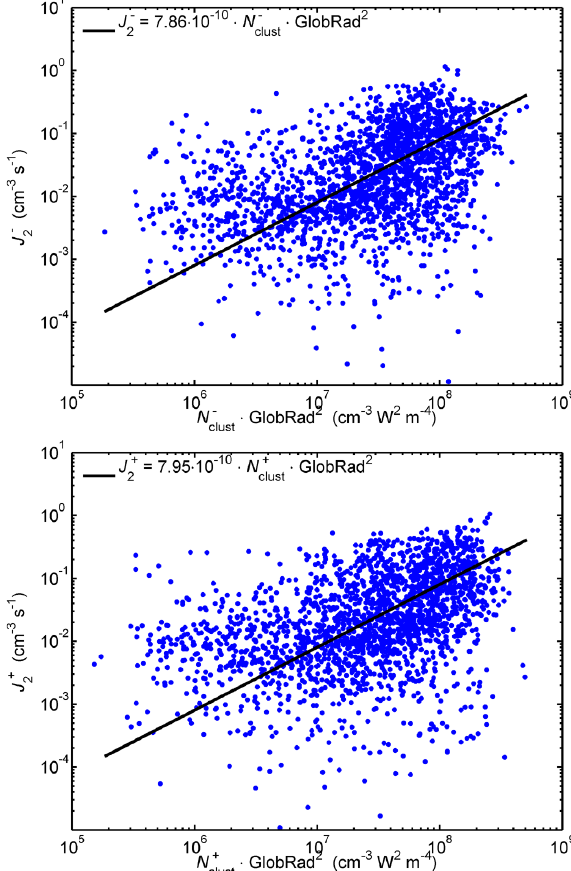
Fig. 3. Ion-induced nucleation rate of (a) negative and (b) positive ions at 2nm as a function of the product of cluster ion concentration and global radiation. The data includes all the 12 EUCAARI mea- surement sites during the 2008–2009 measurement campaign. The color of the data points indicates the intensity of global radiation.